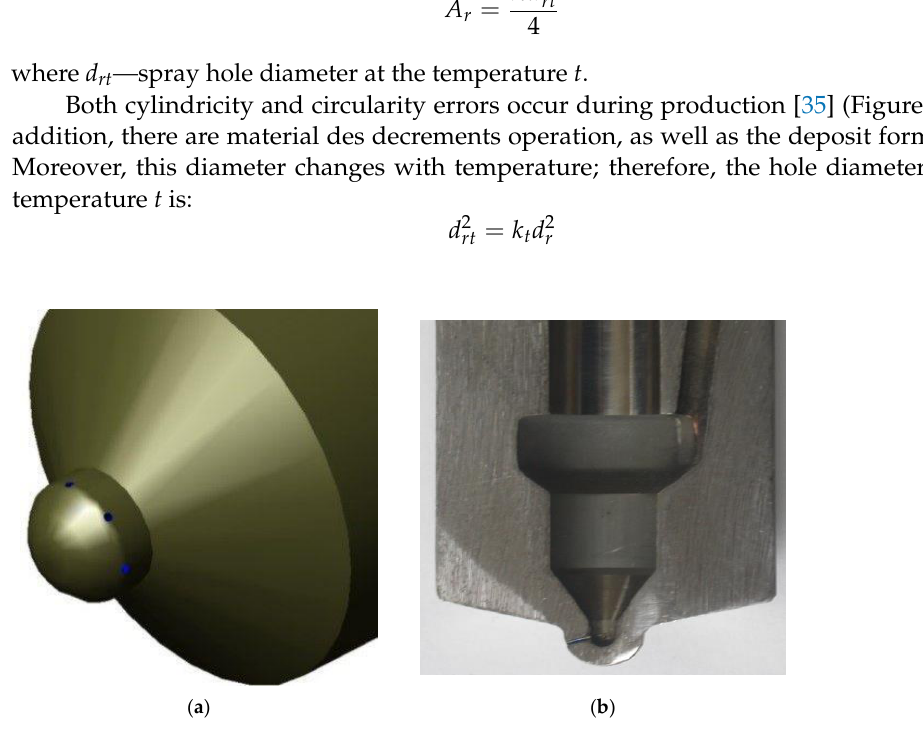
Figure 2. The solid model of the injector nozzle ( a ) and image of cross-section of the nozzle hole with rounding ( b ).